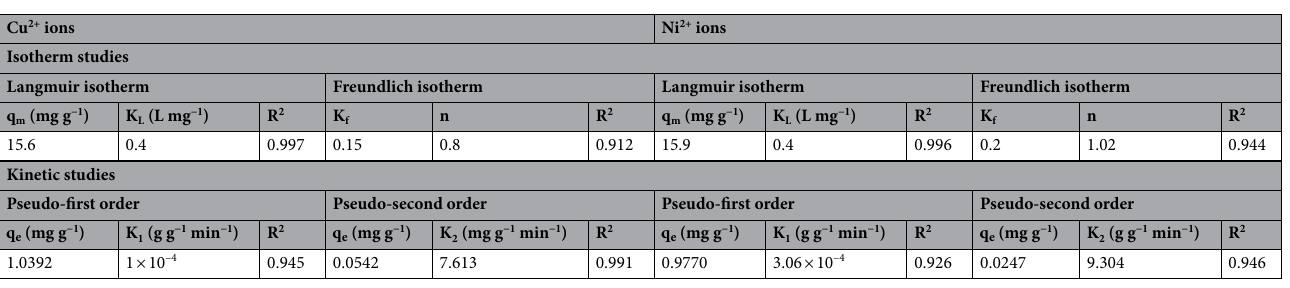
Table 1. Isotherm and Kinetic study parameters for Cu 2+ and Ni 2+